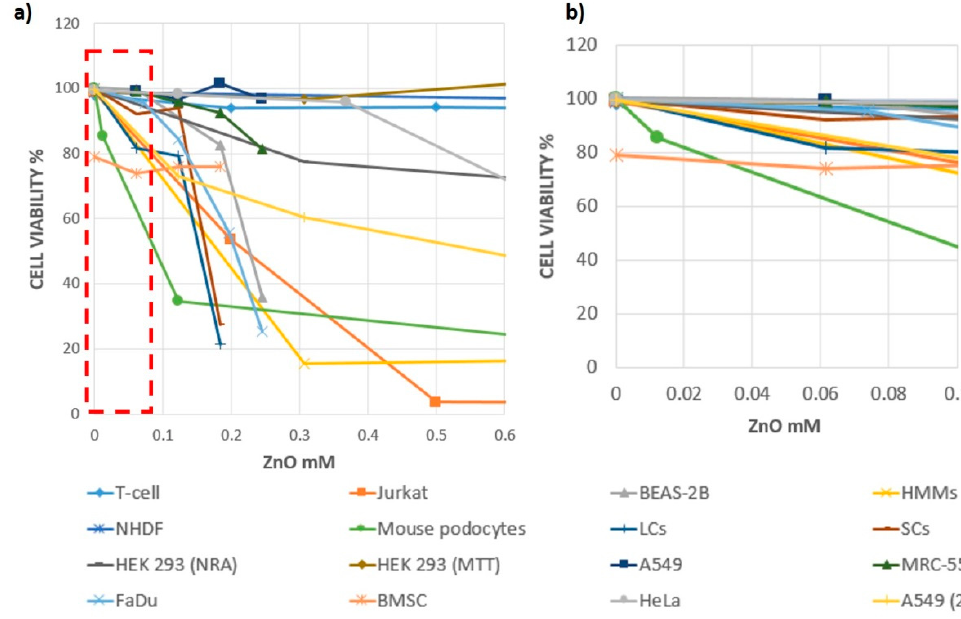
Figure 5. ( a ) Overall elaboration from published data about cell viability vs. ZnO concentration, for different cell lines and different types of nanostructures; ( b ) zoom-in of the red dashed area in ( a ), highlighting the ZnO concentration range where cell viability is preserved and is relatively “safe”. Table 1. Description of the systems analyzed in the graphic reconstruction of Figure 5. MTT, 3-(4,5-